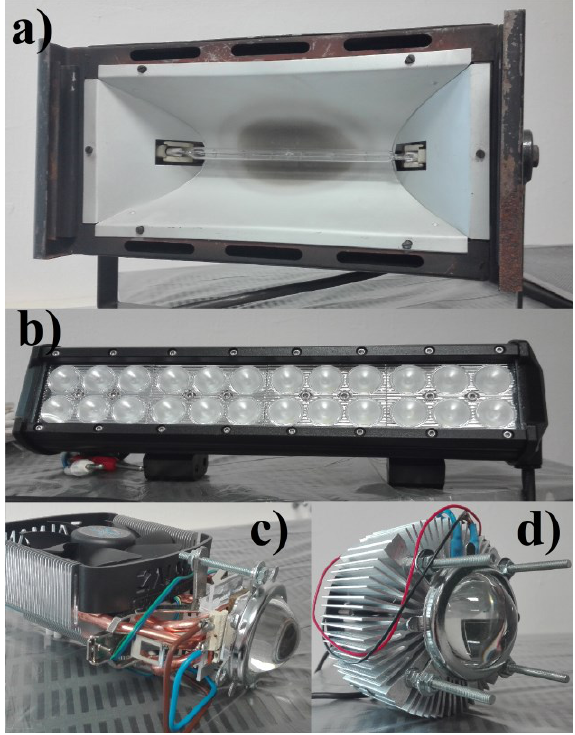
Fig. 2. Light sources: a) 1000 W Halogen lamp; b) 72 W LED bar panel; c) 60 W LED chip; d) 90 W LED